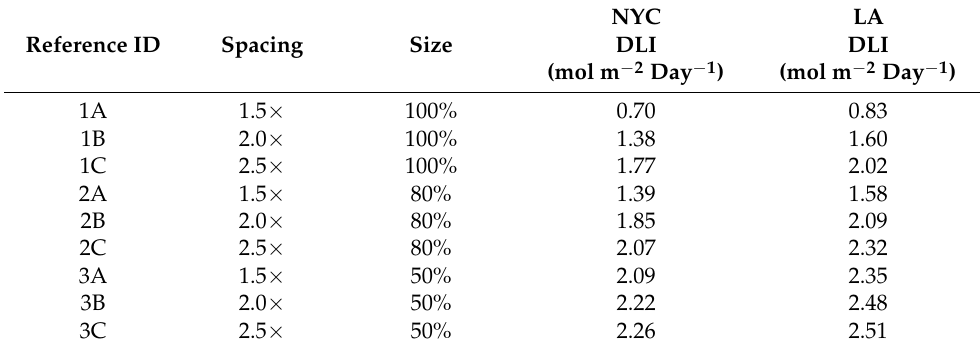
Table 3. Natural light availability for nine urban settings in terms of mean DLI (mol · m − 2 · day − 1 ). Note that the DLI is averaged over the 20-acre production